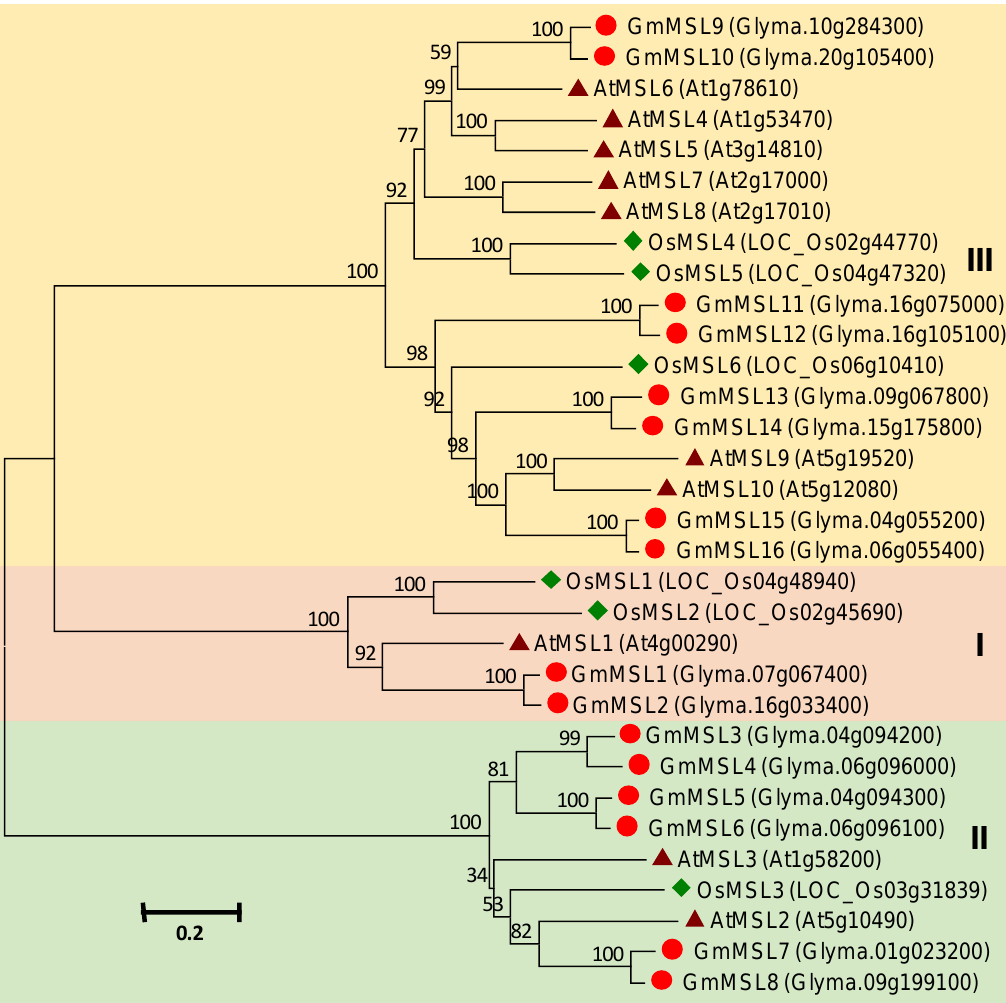
Figure 9. Unrooted phylogenetic tree of the MscS like protein (MSL) family proteins from soybean ( Glycine max ), rice ( Oryza sativa ), and Arabidopsis thaliana . Soybean MSLs are marked with red circles, Arabidopsis MSLs were marked with purple triangles, while rice MSLs were marked with green diamonds. The bar indicates the relative divergence of the sequences examined, and bootstrap values are displayed next to the branch. Roman numerals designate the subfamilies.